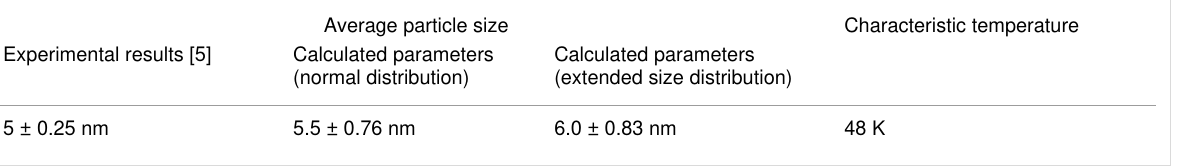
Table 1: Comparison between the experimental results for the particle size according to Woods et al. [5] and the calculated parameters, determined by the assumption of a normal distribution and an extended distribution of the particle size. The results given for the extended size distribution are ob- tained from fitting with the sum of two normal distributions. The average particle size was calculated using